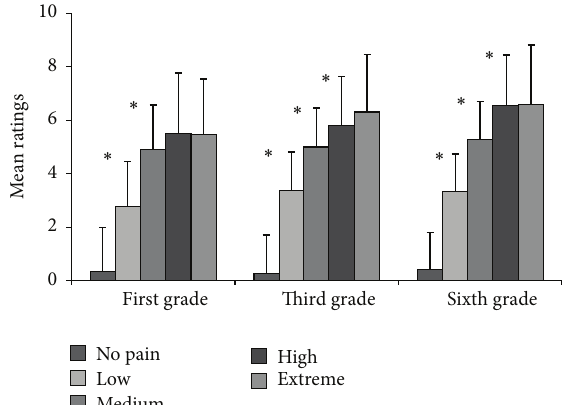
Figure 3: School-aged participants’ mean pain ratings attributed to the different pain intensity levels for visual stimuli depicting faces showing expressions of pain or neutral expressions according to age group. Error bars represent 1SD. Significant differences (𝑃 < 0.005) are indicated by an